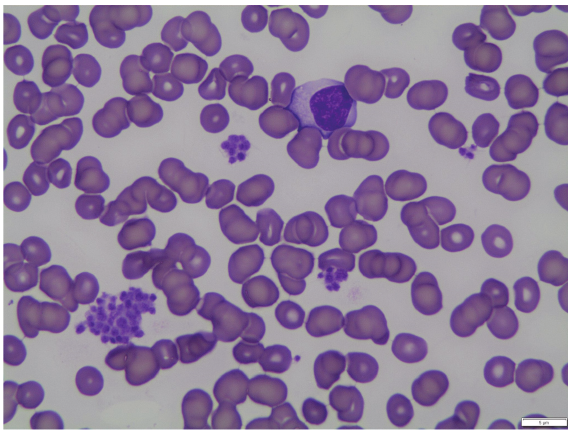
Figure 1: Peripheral blood smear (100x oil).